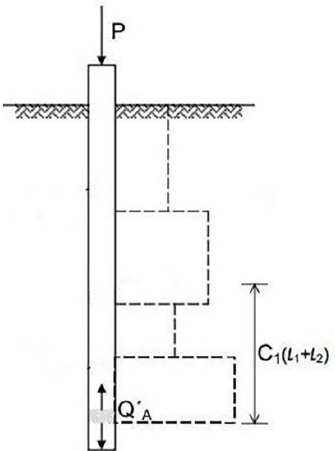
Figure 14. Developed Side Shear Resistance .